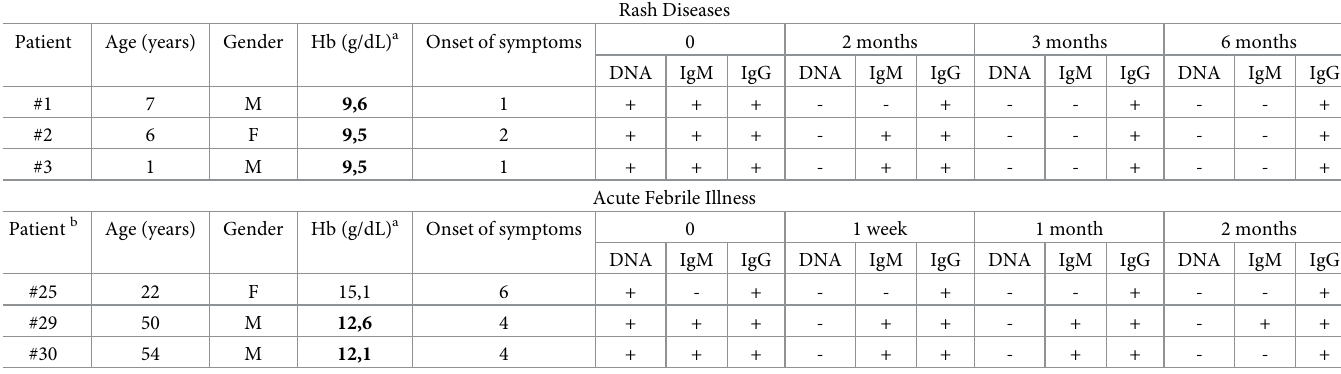
Table 4. Follow-up of molecular and serological markers of Parvovirus B19 among rash diseases (RD) and acute febrile illness (AFI) patients attending in three dif- ferent Hospitals in Rio de Janeiro during 2018–2019. Rash